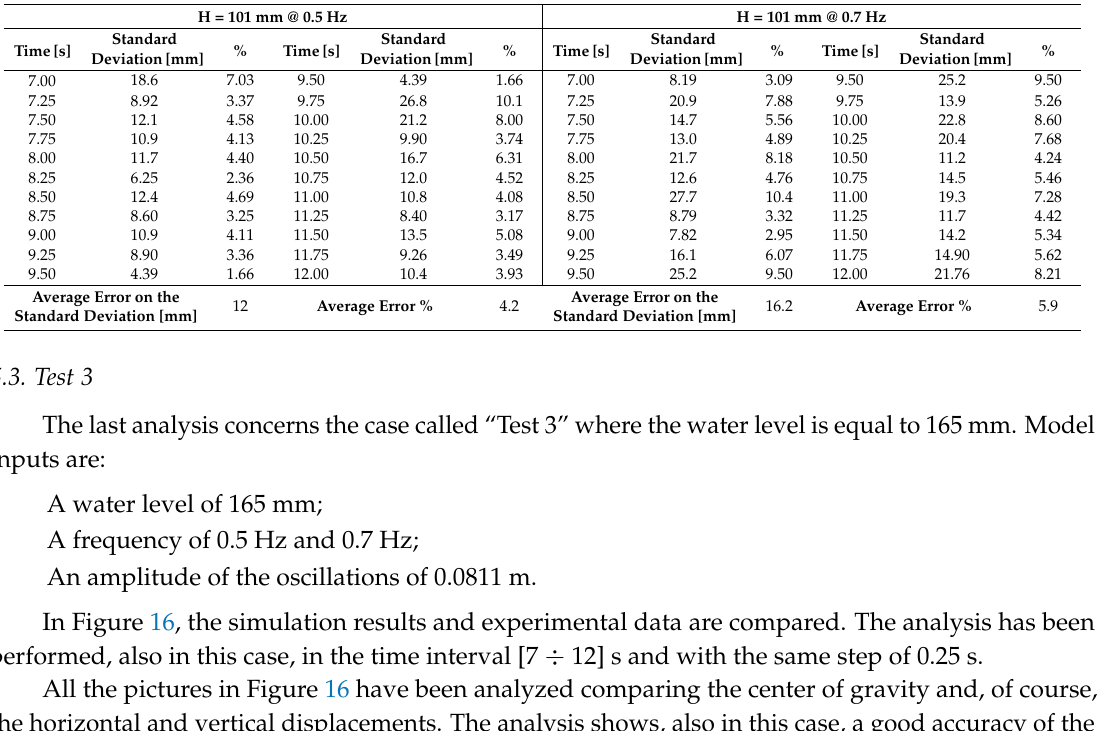
Table 5. Model output for the free surface ( Test 2 ).